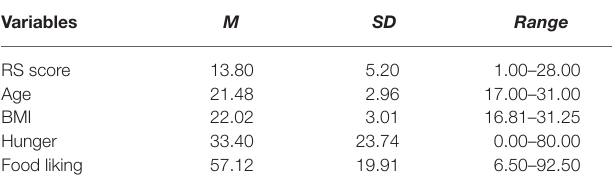
TABLE 1 | Participant